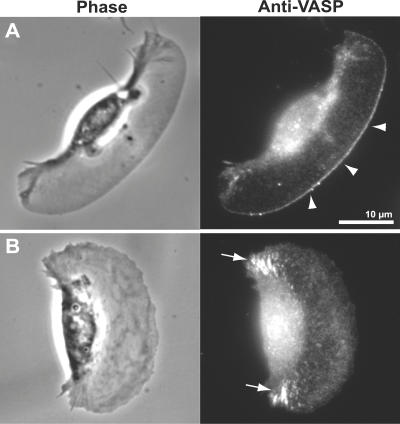
Strong VASP Localization at the Leading Edge Is Observed in Keratocytes with Smooth Leading-Edge MorphologyA population of primary keratocytes is heterogeneous in morphology. (A) Keratocytes can have a smooth leading edge, showing strong VASP immunofluorescence that appears as a thin line at leading edge (arrowheads). (B) Keratocytes may also have rough leading edges with weak or absent VASP at the leading edge. VASP also appears localized at focal adhesions (arrows), which are more apparent in cells with rough leading edges. Immunofluorescence was performed using polyclonal anti-murine VASP antibodies. Scale bar = 10 μm.